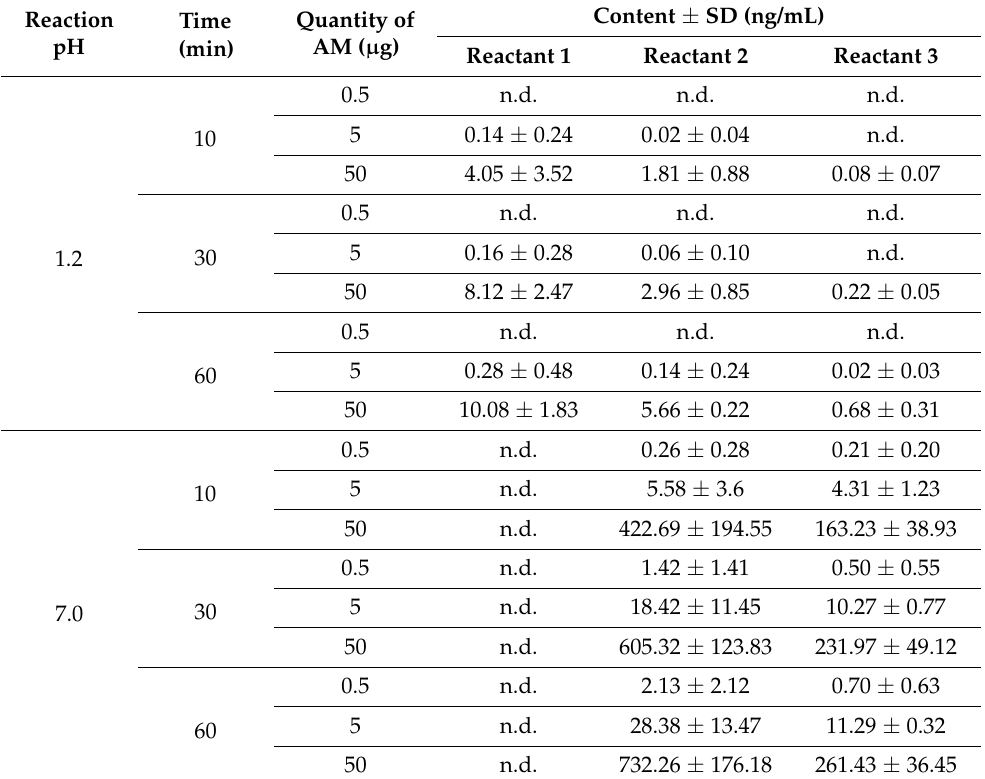
Table 3. The yield of each reactant after reaction with 400 µ g of thymoquinone and each quantity of allyl mercaptan